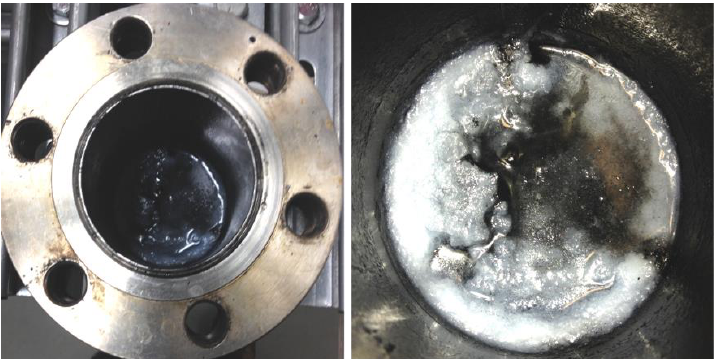
Figure 3. The sample pictures showing a massive wax formation in the reactor after an FTS reaction by carbon-supported catalysts that are evidently black with the wax being conspicuously